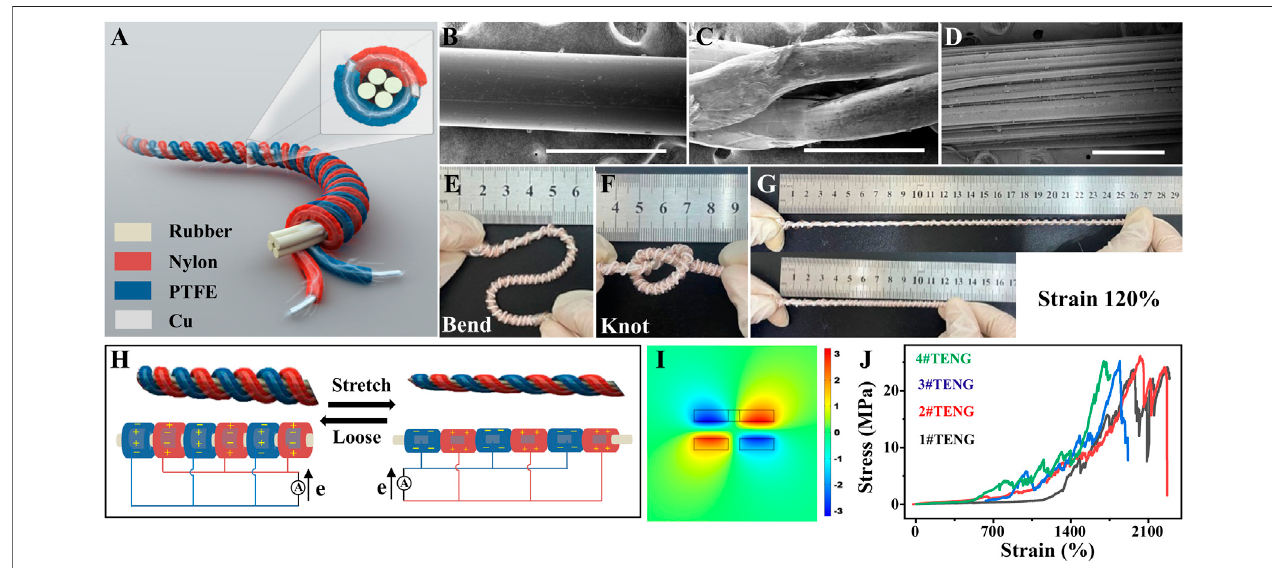
FIGURE 1 | Structure and working mechanism of the TENG. (A) Structural diagram of the TENG. (B – D) SEM images of the rubber fi ber, the nylon fi ber, and the PTFE fi ber, respectively. Scalebar in (B – D) is 500 μ m. (E – G) Photograph of the fl exible and stretchable TENG in different shapes. (H) Working principle of the TENG. (I) Numerical calculation of the corresponding electrical potential distribution by COMSOL software. (J) Stress – strain curve of the four identical TENGs.